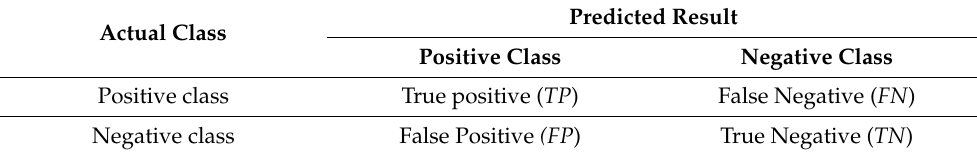
Table 2. Confusion matrix.